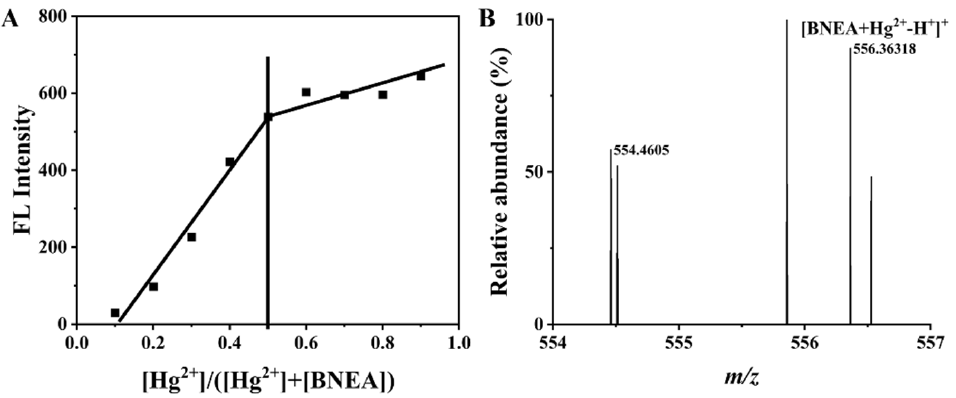
Figure 11. ( A ) The Job’s plot for BNEA (10 μ M) towards Hg 2+ in 99% aqueous solution (V H2O :V DMSO = 99:1), ( B ) HRMS (ESI) spectra of BNEA with Hg 2+ in methanol solution.